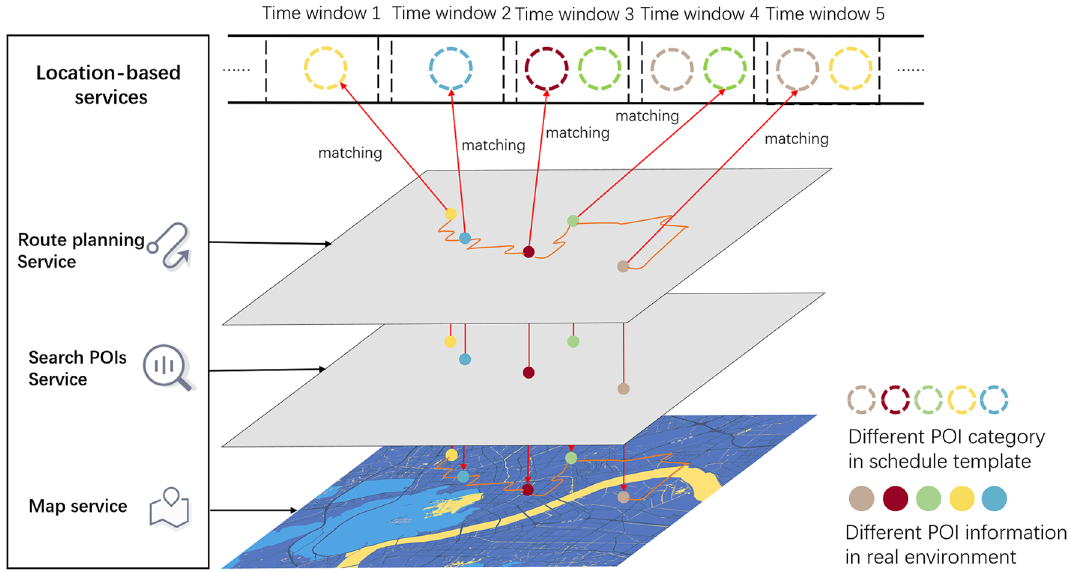
Figure 3. Generating agent-specific schedule with LBS. According to the order of the schedule template, send a request to the LBS provider (which provides the search POIs service), match the POI information to the schedule template, and use the obtained POI information to continue to send a request to the POI provider (which provides the route planning service) to get the corresponding trajectory data. Repeat these steps